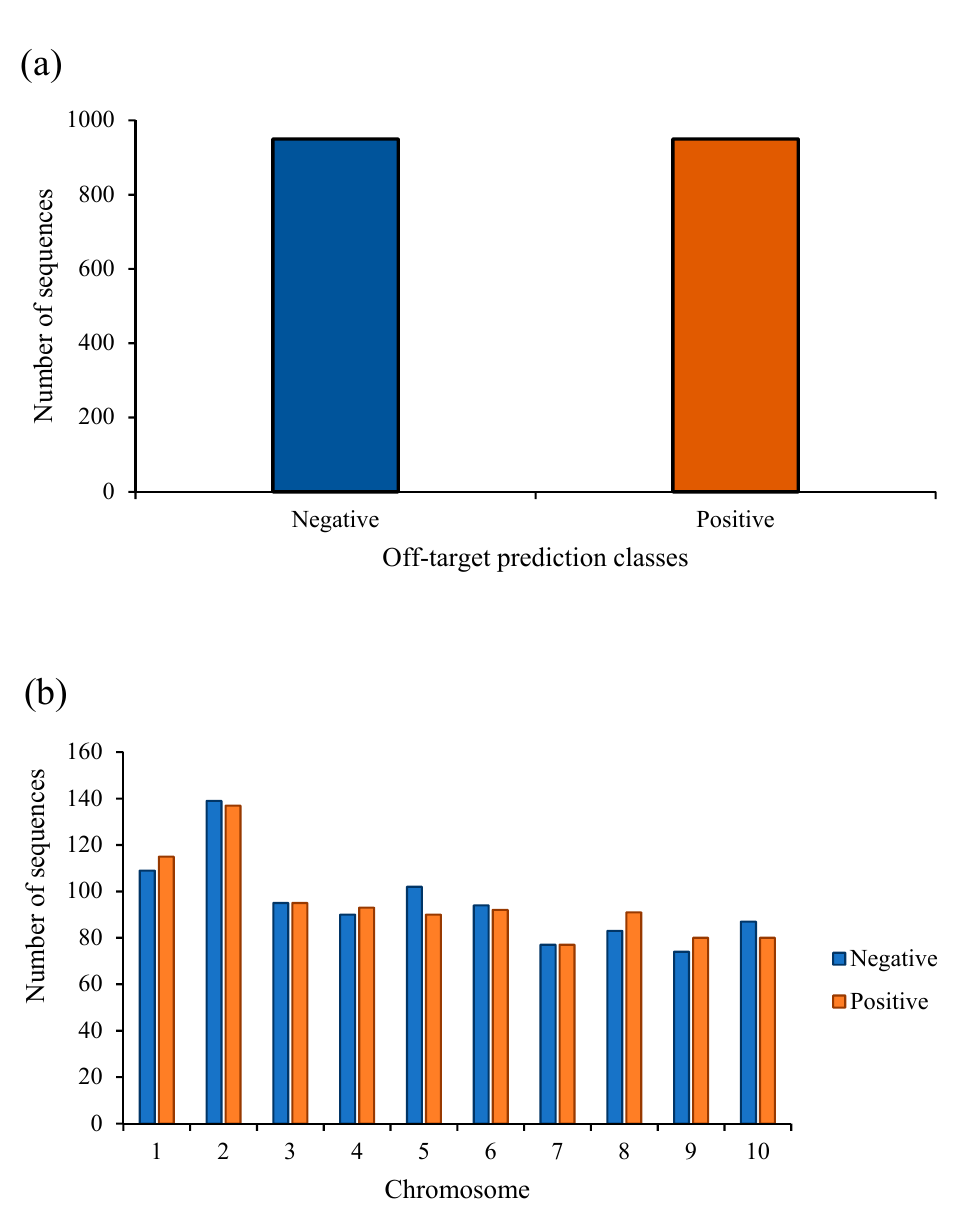
Figure 6. The distribution of off-target prediction classes in ( a ) the whole database and ( b ) each chromosome with respect to CFD and MIT scores.